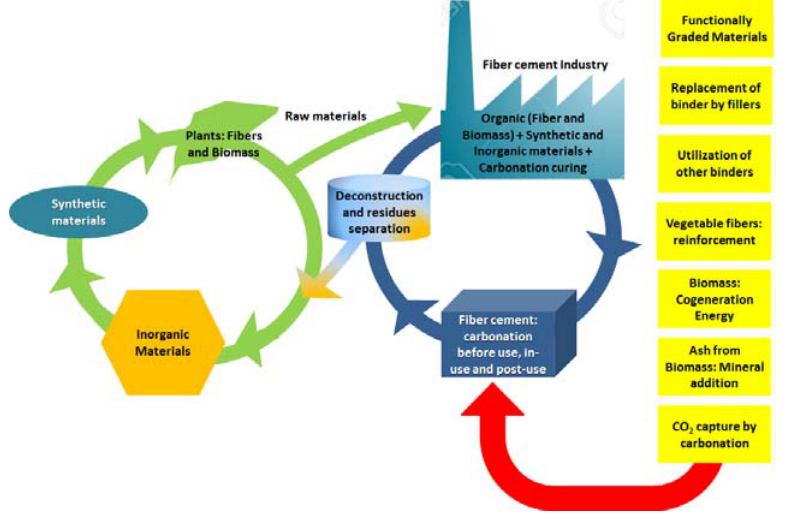
Figure 2. Schematic diagram showing a concept process consisting of different approaches to improve the sustainability of the fiber cement industry.